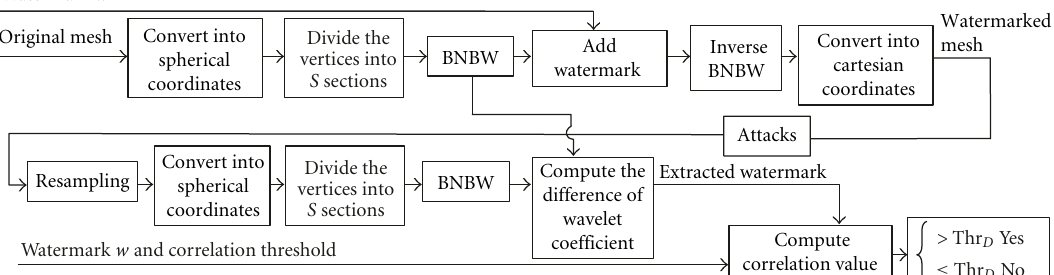
Figure 1: Outline of the proposed BNBW-based watermarking